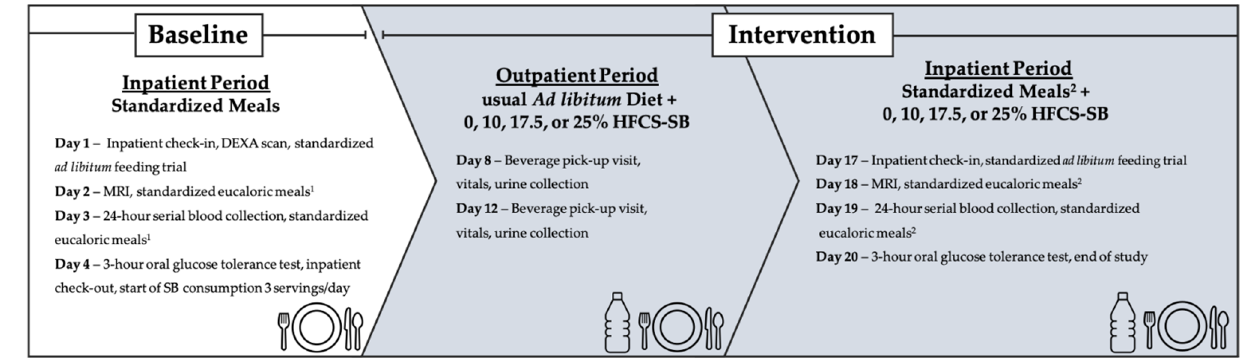
Figure 1. Study design and experimental testing and collection days. DEXA, dual energy x-ray ab- sorptiometry; MRI, magnetic resonance imaging; SB, sweetened beverage; HFCS, high fructose corn syrup. 1 Fifty-five percent complex carbohydrate (<2%added sugar), 35% fat, 15% protein. 2 55–30% complex carbohydrate (depending on assigned SB, <2%added sugar), 35% fat, 15% protein. % = % of energy requirement.